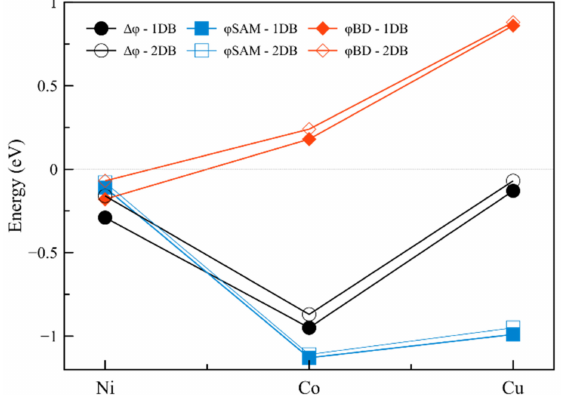
Figure 2. Work function shifts (black dots) and its two contributions: molecular, ϕ SAM (blue squares) and bond dipole, ϕ BD (red diamonds) of nickel, cobalt and copper interfaces with one (filled symbols) and two double bonds (empty